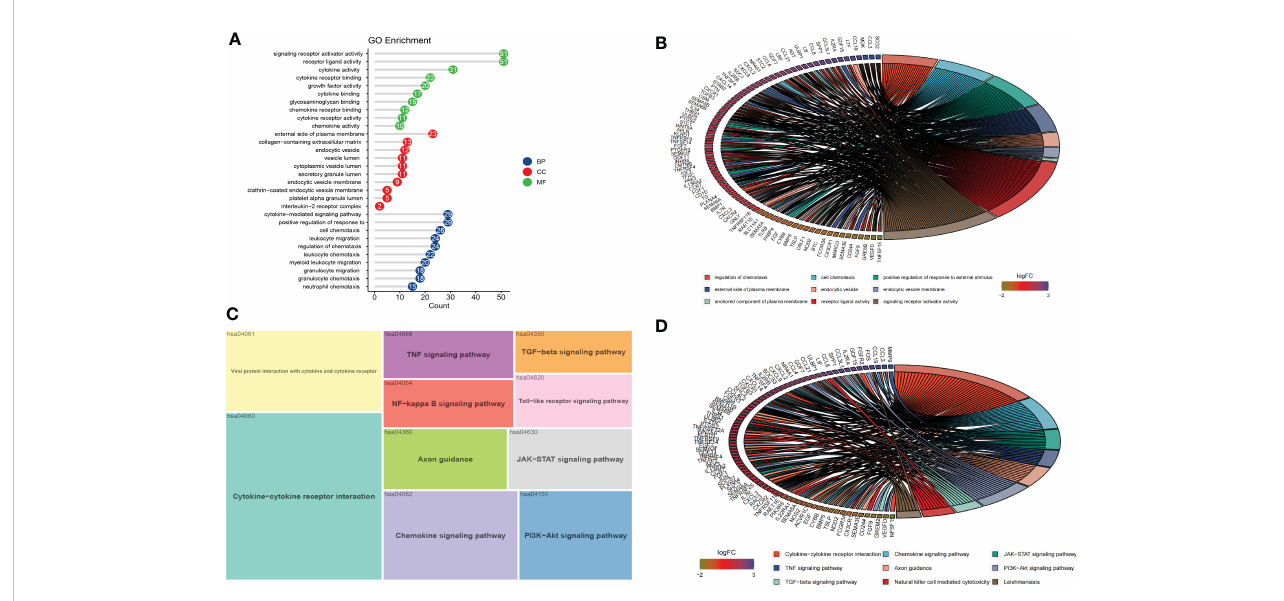
FIGURE 3 Functional enrichment and PPI of DEIRGs. (A, B) The results of GO analysis were displayed in lollipop and circle charts. (C, D) The results of KEGG analysis were displayed in treemap and circle